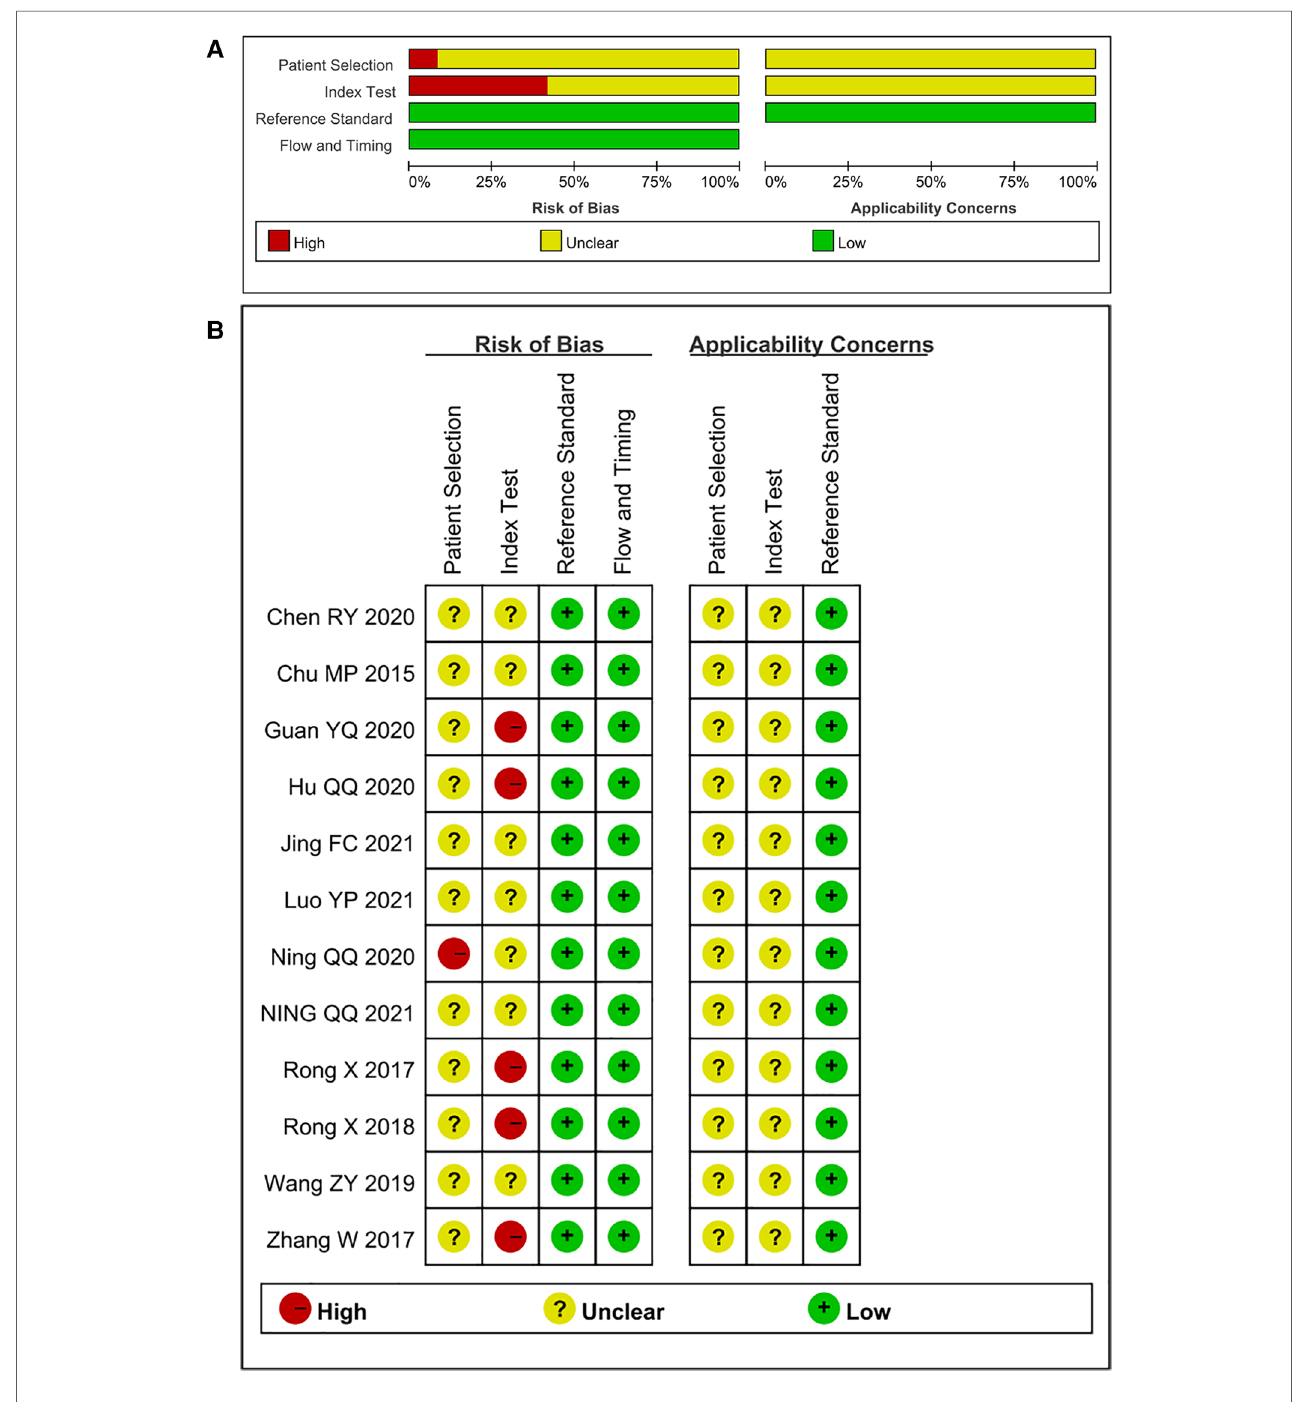
FIGURE 2 ( A ) risk of bias and applicability concerns graph: reviews the judgments of the author about each domain presented as percentages across included studies. ( B ) Risk of bias and applicability concerns summary: reviews judgments of the author about each domain for each included